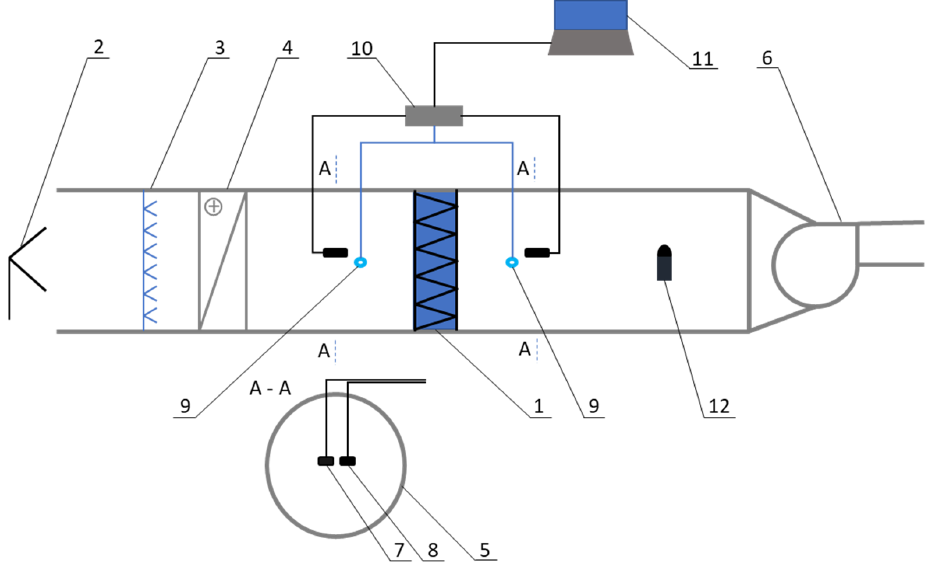
Figure 3. Overview of experimental stand: 1—filter, 2-source of dust, 3—humidifier, 4—heater, 5—vent pipe, 6—fan, 7—mass concentration sensor (SPS 30), 8—temperature and humidity sensor, 9—differential pressure gauge, 10—measuring card, 11—computer, 12—handheld air speed meter. The